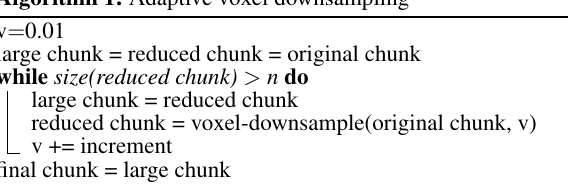
Algorithm 1: Adaptive voxel downsampling